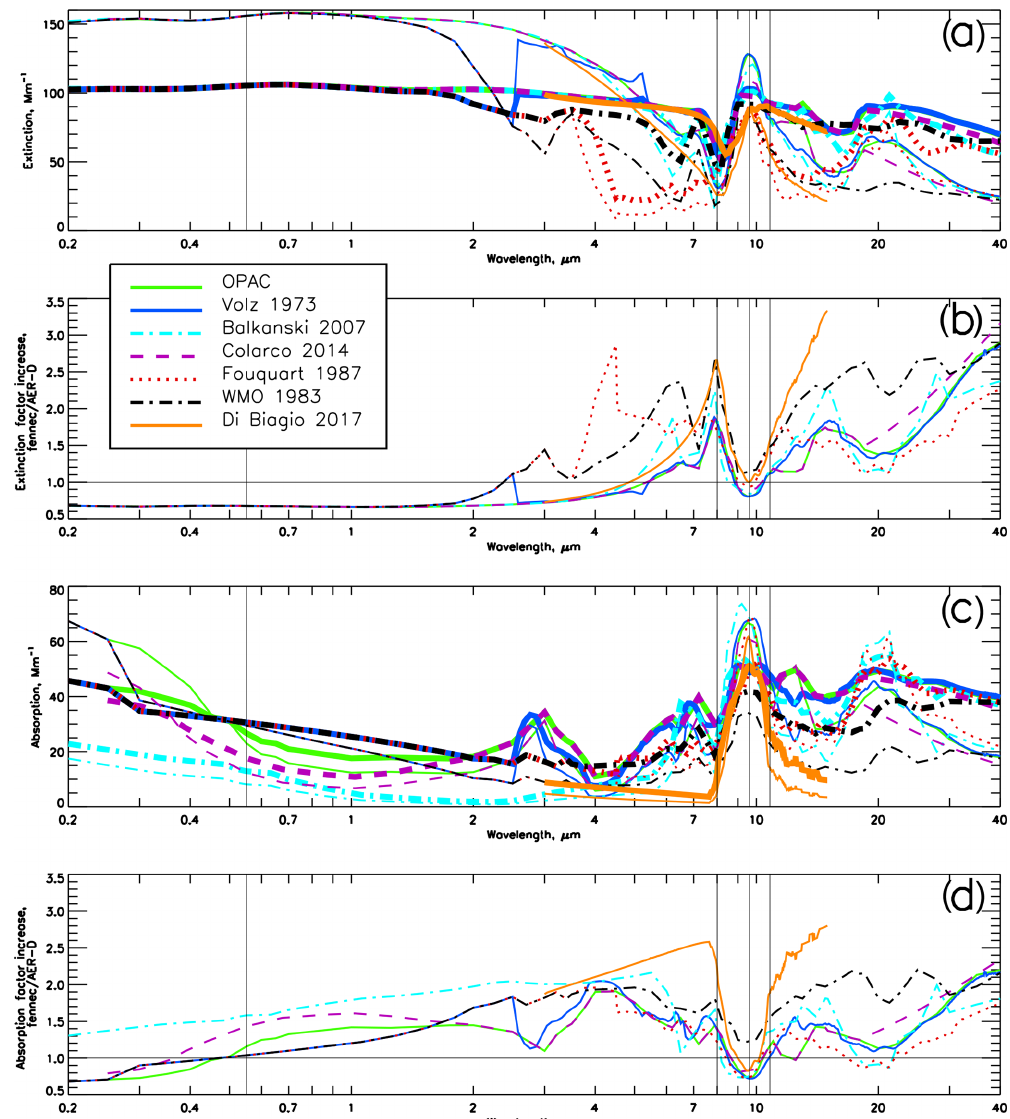
Figure 6. Calculated spectral extinction coefficient (Mm − 1 ) (a) and factor increase in extinction (b) between Fennec-Sahara (bold lines) and AER-D-SAL (lightweight lines), calculated spectral absorption coefficient (Mm − 1 ) (c) , and factor increase in absorption (d) between Fennec-Sahara (bold lines) and AER-D-SAL (lightweight lines). Different colours indicate different RI datasets as in the legend. Vertical lines indicate 0.55, 8.0, 9.6, and 10.8µm